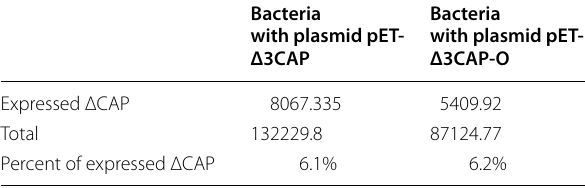
Table 2 The grey value of expressed ΔCAP band and total bacteria analyzed by the ImageJ software